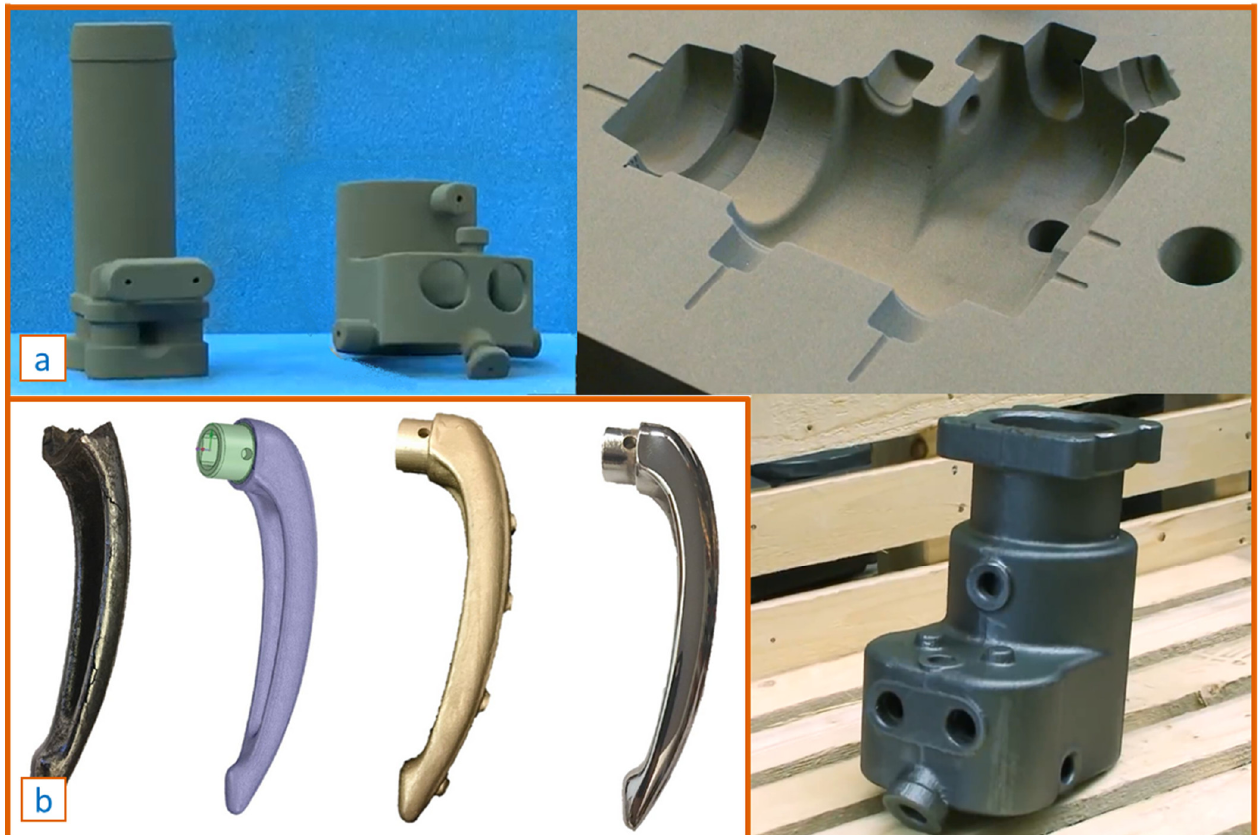
Figure 6. Polymer spare-part reconstruction based on indirect AM processes: ( a ) Sand mould and cores for casting a 1912 one-cylinder car engine (photo credits: 3Dealise). ( b ) Investment cast door handle (photo credits: Rare Parts Club, a division of Freshmade 3D).